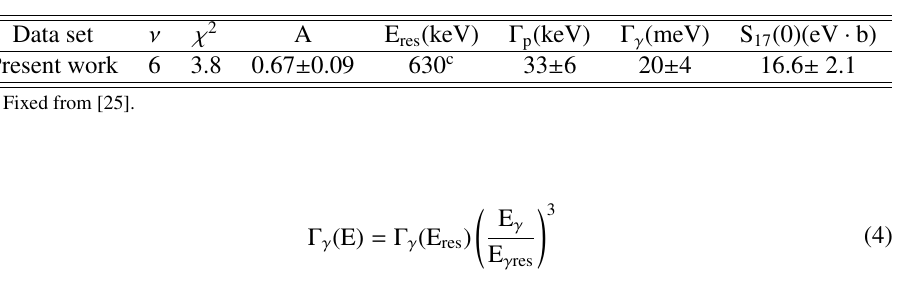
Figure 2. The red stars represent the cross section values obtained in the present work. The dotted black line represents the fit of [1]. The solid red line represents the model from equation 2 fitted to present work data. Table 1. Fit results to our data using the function in eq. 2. ν indicates the number of degrees of